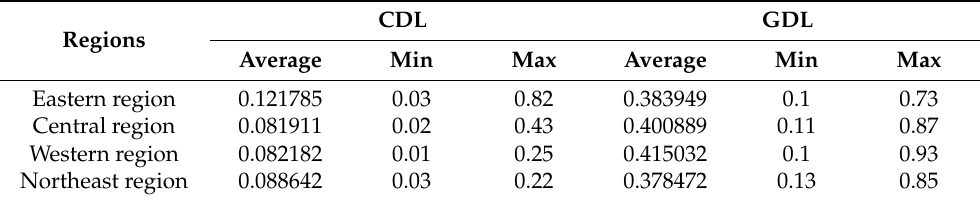
Table 2. Descriptive statistics of CDL and GDL composite scores for four economic zones. CDL GDL Regions Average Min Max